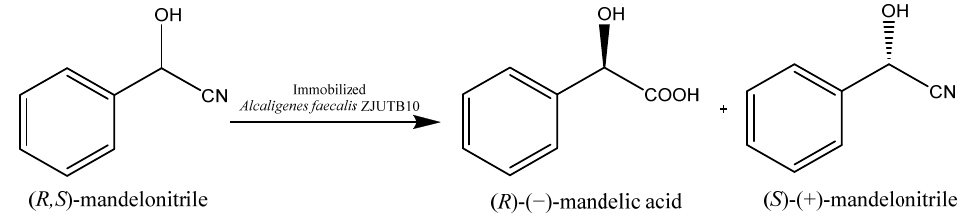
Figure 4. Structure of ( R,S )-carvedilol.